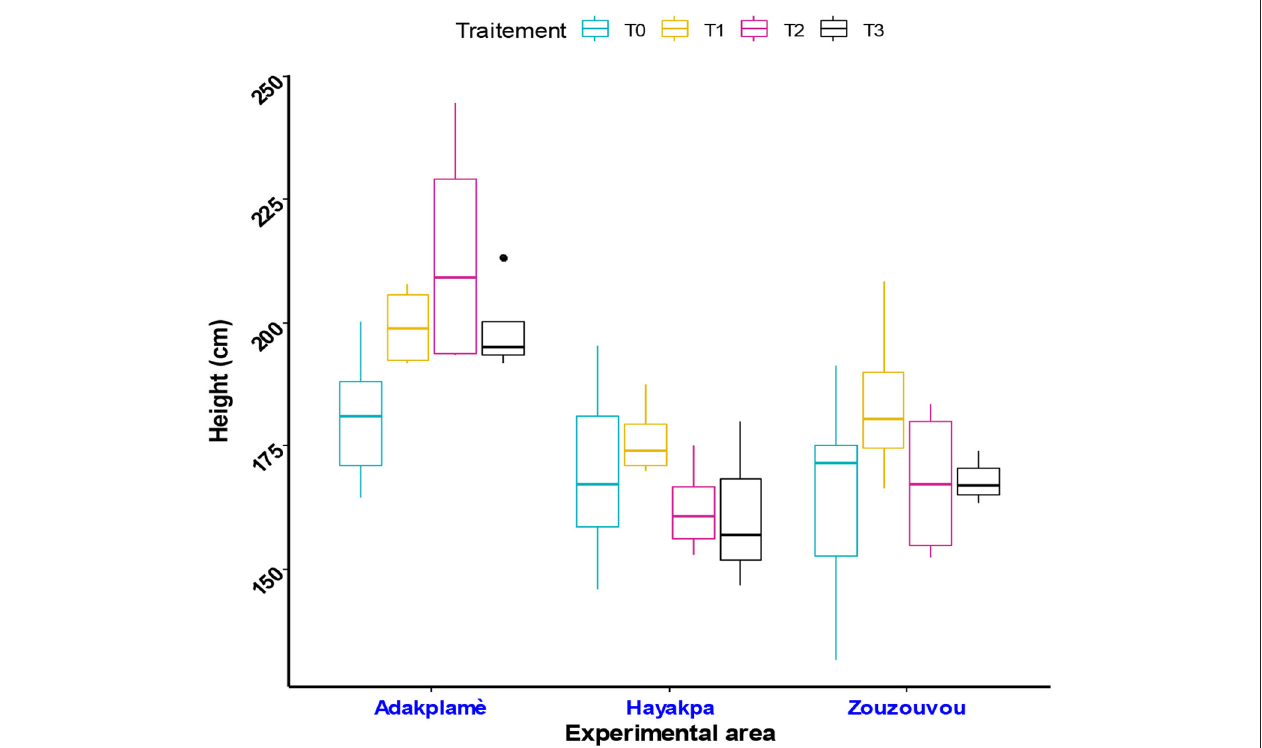
FIGURE 2 | Height of maize plants as a function of treatments by zone. T 0 :100% NPK + urea; T 1 : clay + P. putida + ½ NPK + Urea, T 2 : peat + P. putida + ½ NPK + Urea, T 3 : clay-peat + P. putida + ½ NPK +